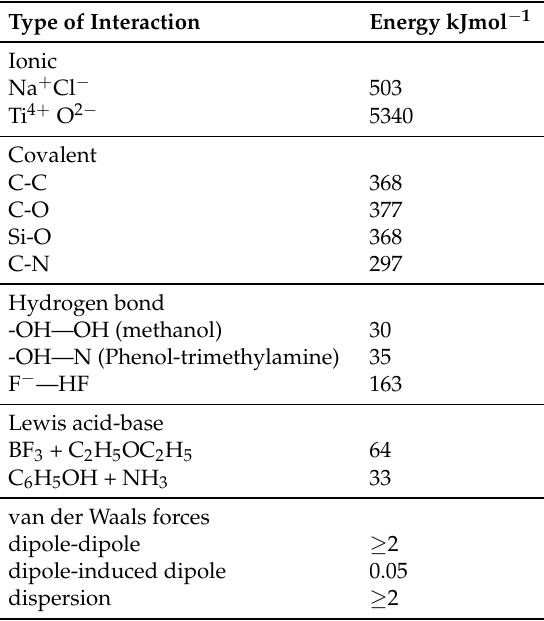
Table 3. Typical strength of attraction forces, data from